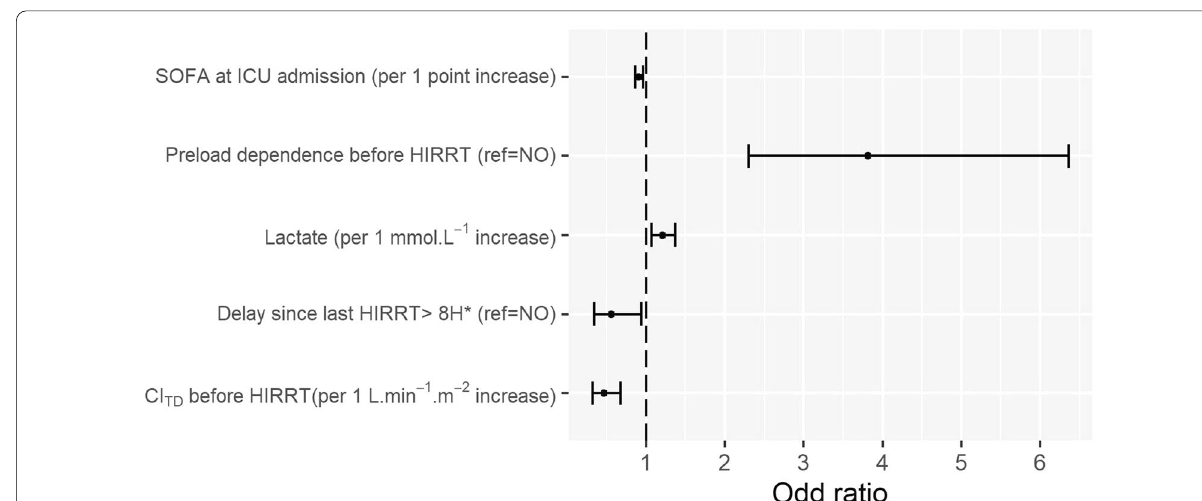
Fig. 5 Forest plot of risk factors for occurrence of HIRRT associated with preload‑dependence in multivariate analysis. Bars are 95% confidence interval of odds ratios.